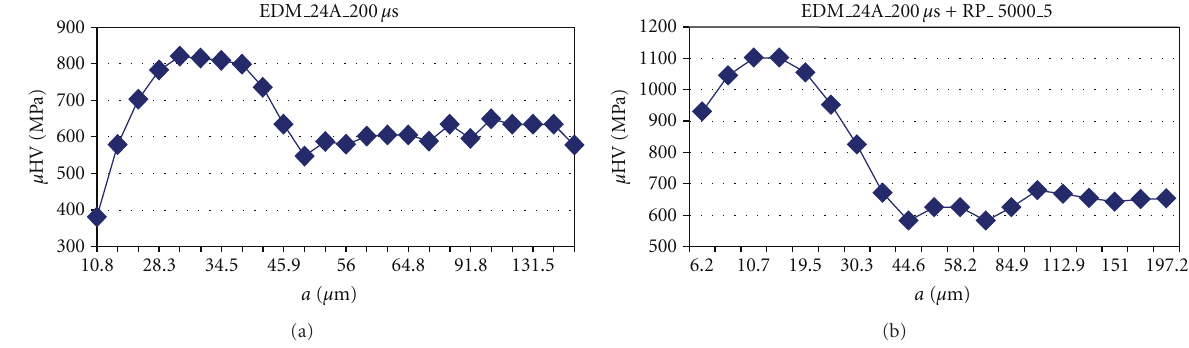
Figure 7: Microhardness distribution in surface layer for EDM U = 120 (V), I = 24 (A), Ti = 200 ( μ s), and machined by the EDM and roto-peen n = 5000 (rev/min), t = 5(min).